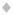
Phylogenetic reconstruction and amino acid variants shared among different U.S. HSV-2 clusters.Amino acid sequences in the SD90e reference strain correspond to gI (highlighted in green), gE (yellow), US8A (orange) and US9 (grey). Each gene segment is also bracketed at the bottom of the figure. Amino acid sequences were ordered according to the Bayesian tree diagrammed on the left side of the figure. Blue and red accession numbers represent, respectively, non-recurrent and recurrent isolates (Table 2). Selected regions with amino acid variation are shown. The position of each amino acid variant shared by non-related clusters (♦) or at which multiple amino acid variants occur (♦) is indicated above the reference strain. Bayesian posterior probabilities (≥80%) and maximum-parsimony bootstrap (≥65%) / maximum-likelihood bootstrap (≥65%) values appear above and below the branches, respectively. * High-passage laboratory strain.